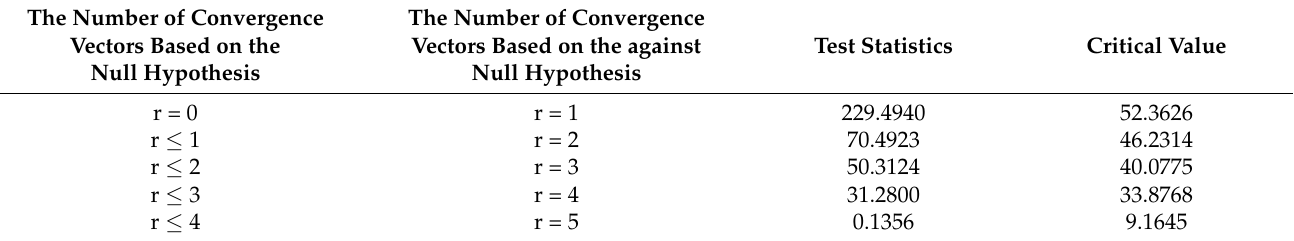
Table 6. The results of the cointegrated test based on maximum engine value statistics.